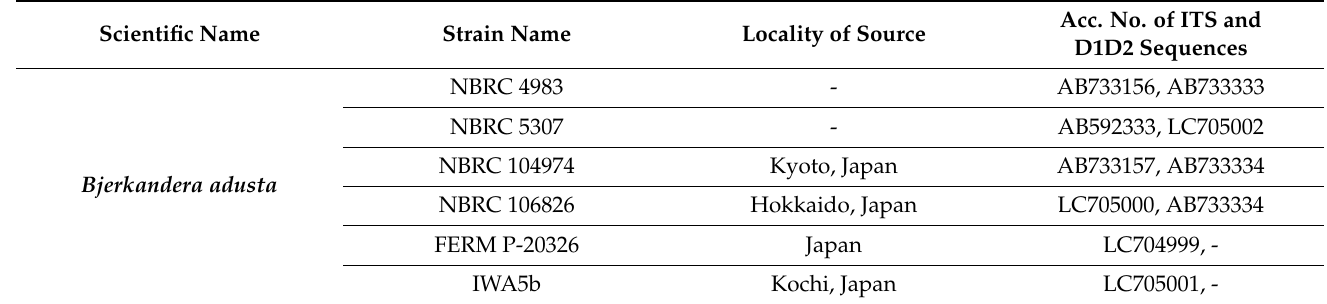
Table 1. List of analyzed fungal